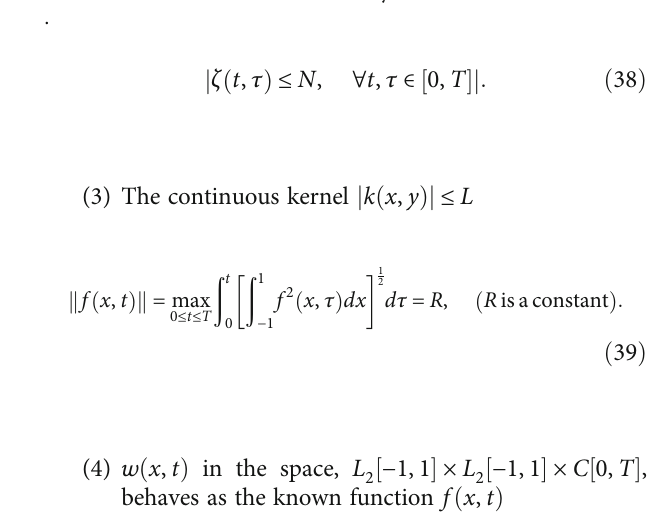
Figure 14: The value absolute error by TMM at N = 10 and T = 0 : 2